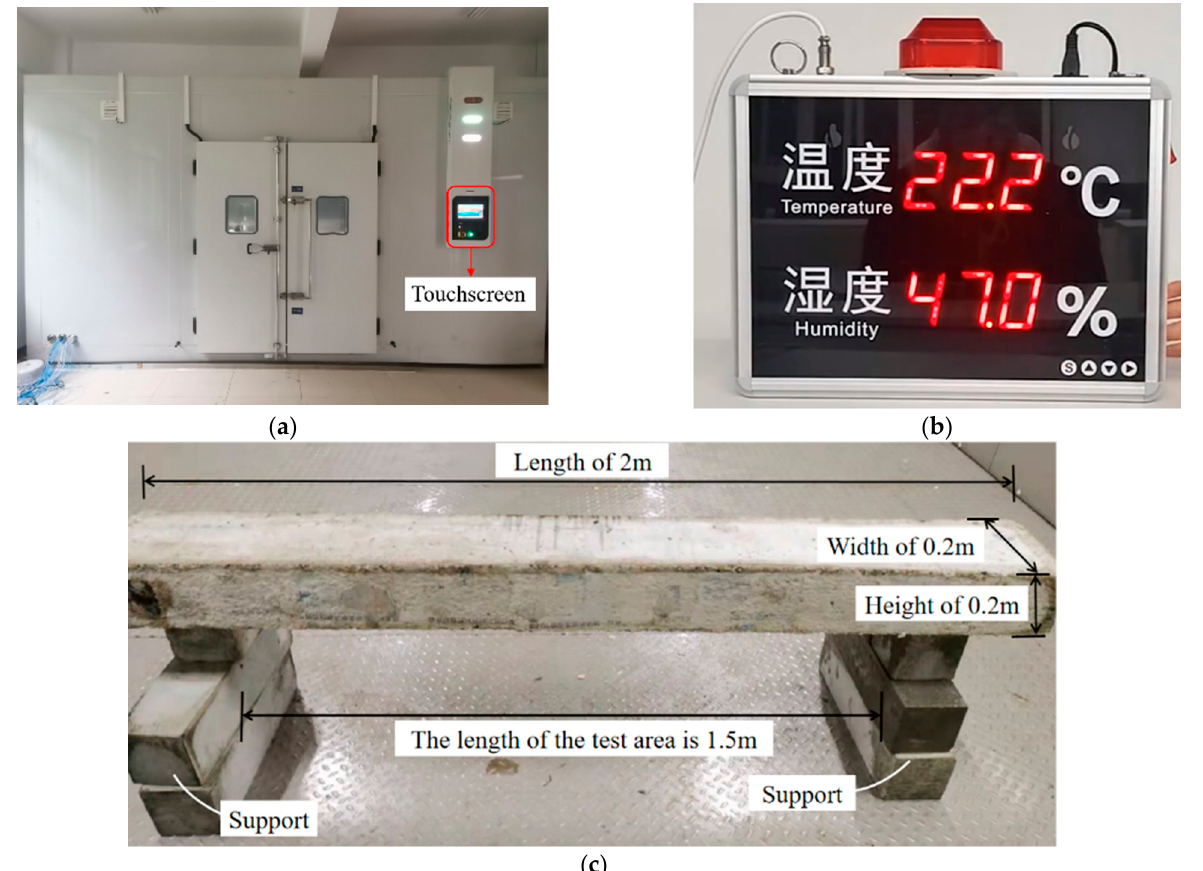
Figure 5. ( a ) The cold chamber; ( b ) the temperature and humidity recorder; ( c ) the dimension information of the model beam.